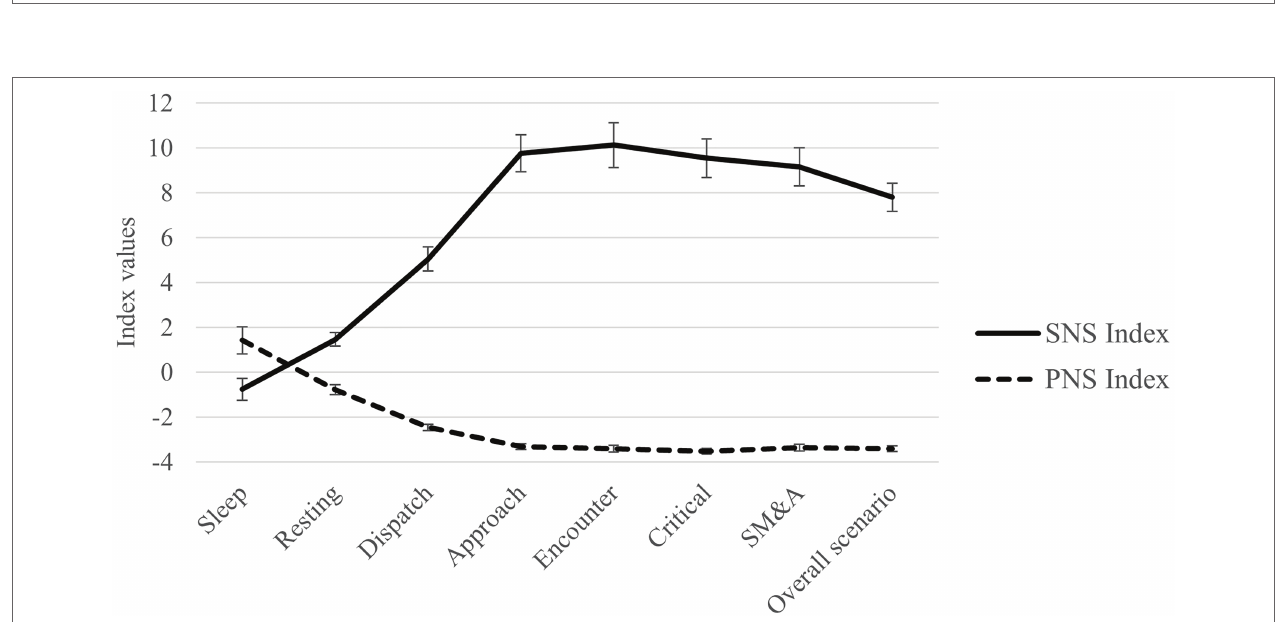
FIGURE 1 | Heart rate (HR) during sleep, while at rest, and during the phases of the scenario. bpm, beats per minute and SM&A, scene management and aftercare. 95% CI error bars displayed.